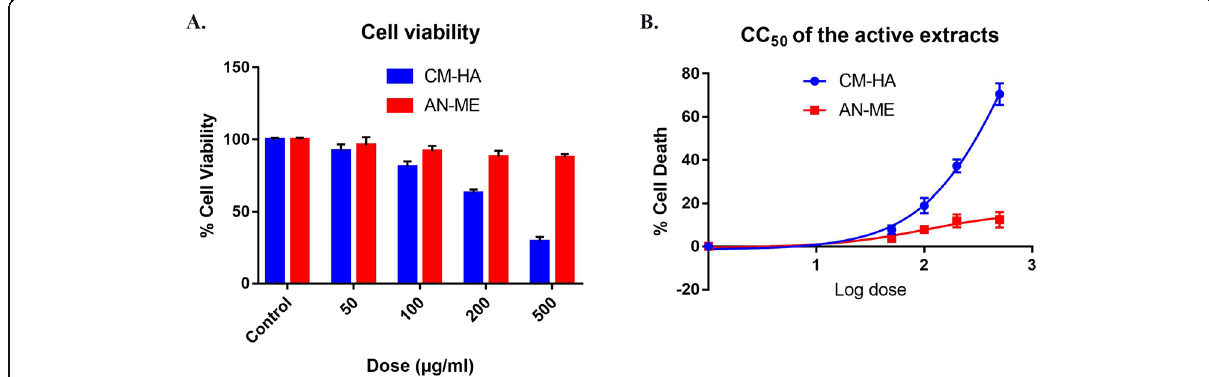
Fig. 3 Cytotoxic effects of the active extracts of C. maxima and A. nilagirica on murine macrophage RAW264.7 cell line; a Cell viability after treatment of 24 h with the different dose of the extracts. b Determination of CC 50 values of the two extracts (CM-HA and AN-ME).